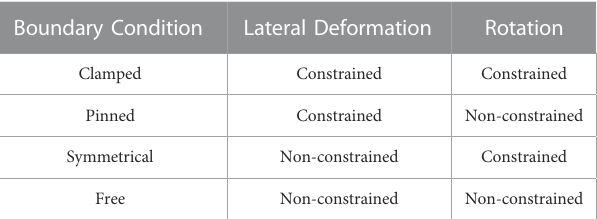
TABLE 1 Constrained degrees of freedom for the potential boundary conditions of the plate